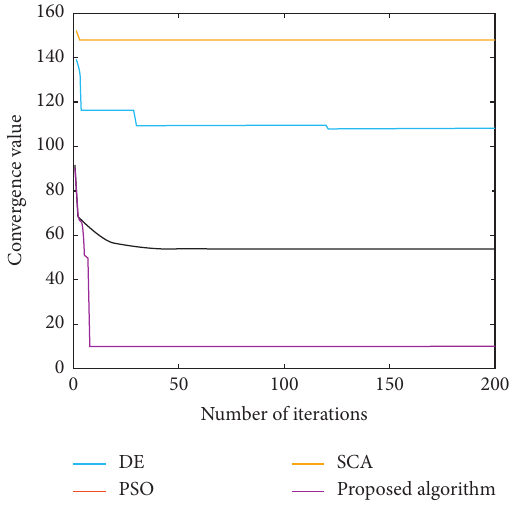
Figure 10: Convergence curve.